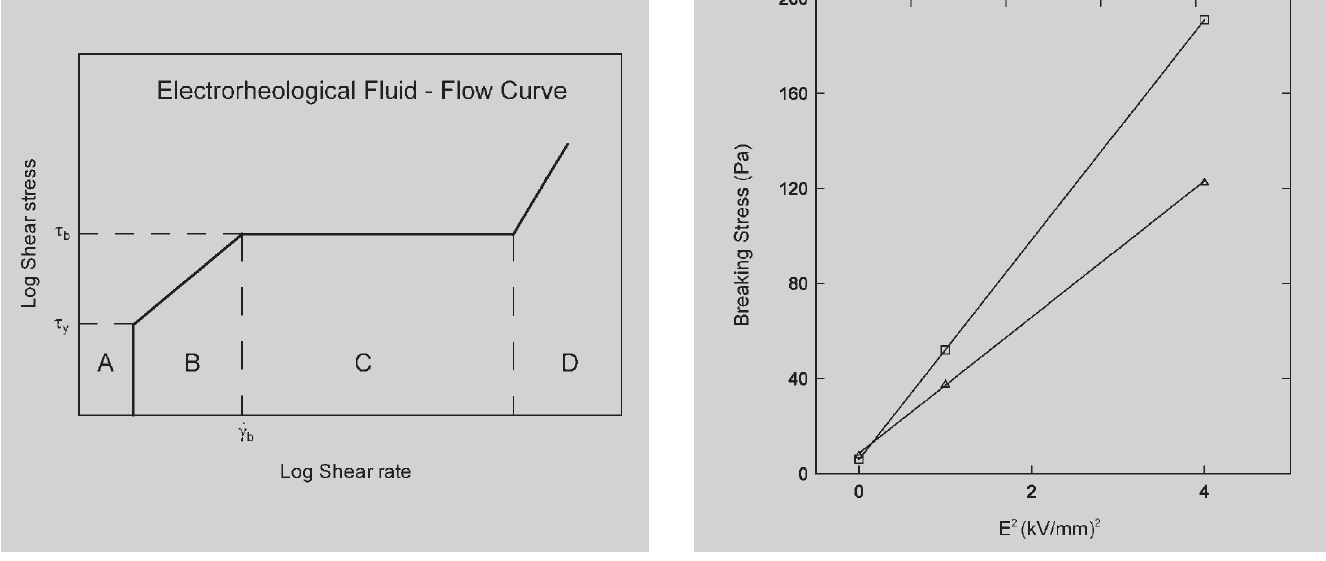
Figure 4: Schematic representation of the flow curve of an electrorheological suspen- sion measured in CSS mode. Figure 5: Breaking shear stress as a function of E 2 for suspen- sions of uncoated ( Û ) and PANI-coated silica particles ( ·